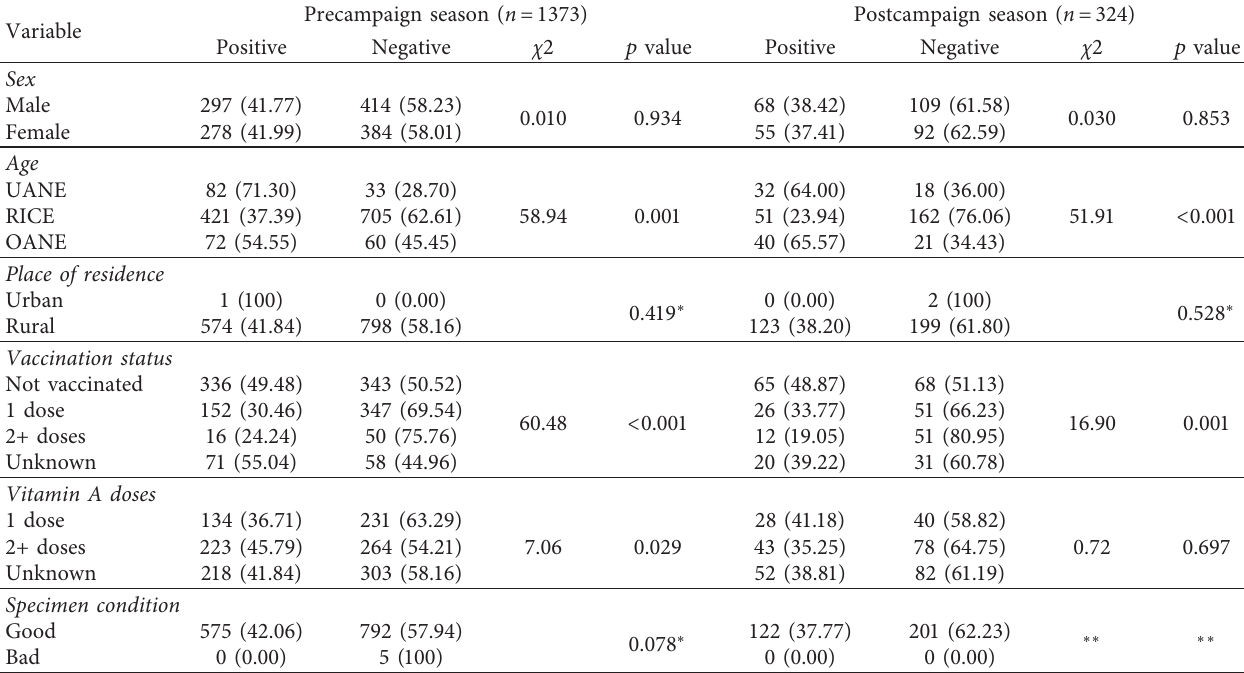
Table 2: Factors associated with the measles outcome among laboratory-examined cases before and after the 2019 measles-rubella mass vaccination